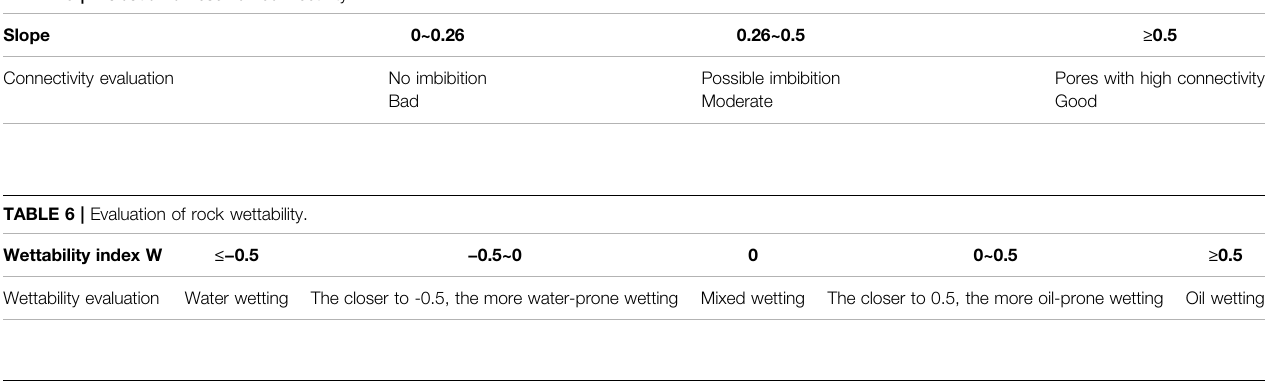
TABLE 7 | Connectivity and wettability evaluation of organic-rich grapholith shales and organic-rich mixed shales.